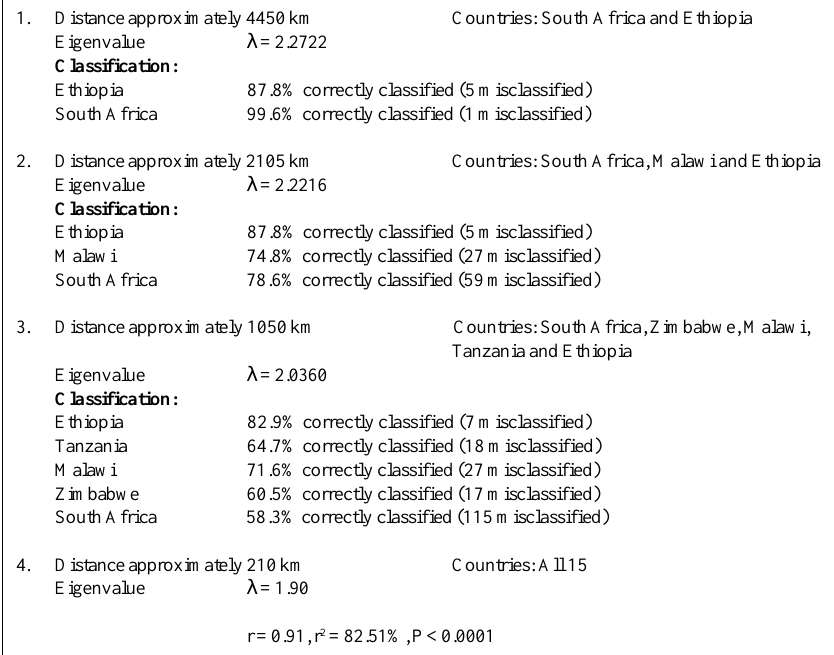
Table II - The effects of sampling distance intervals on morphocluster